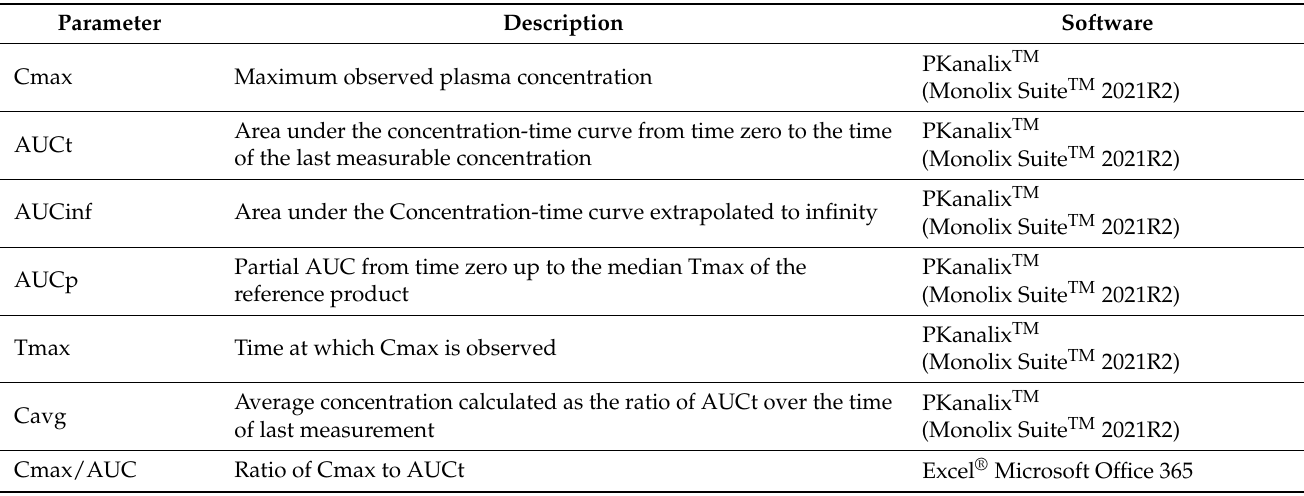
Table 1. Pharmacokinetic parameters utilized in the